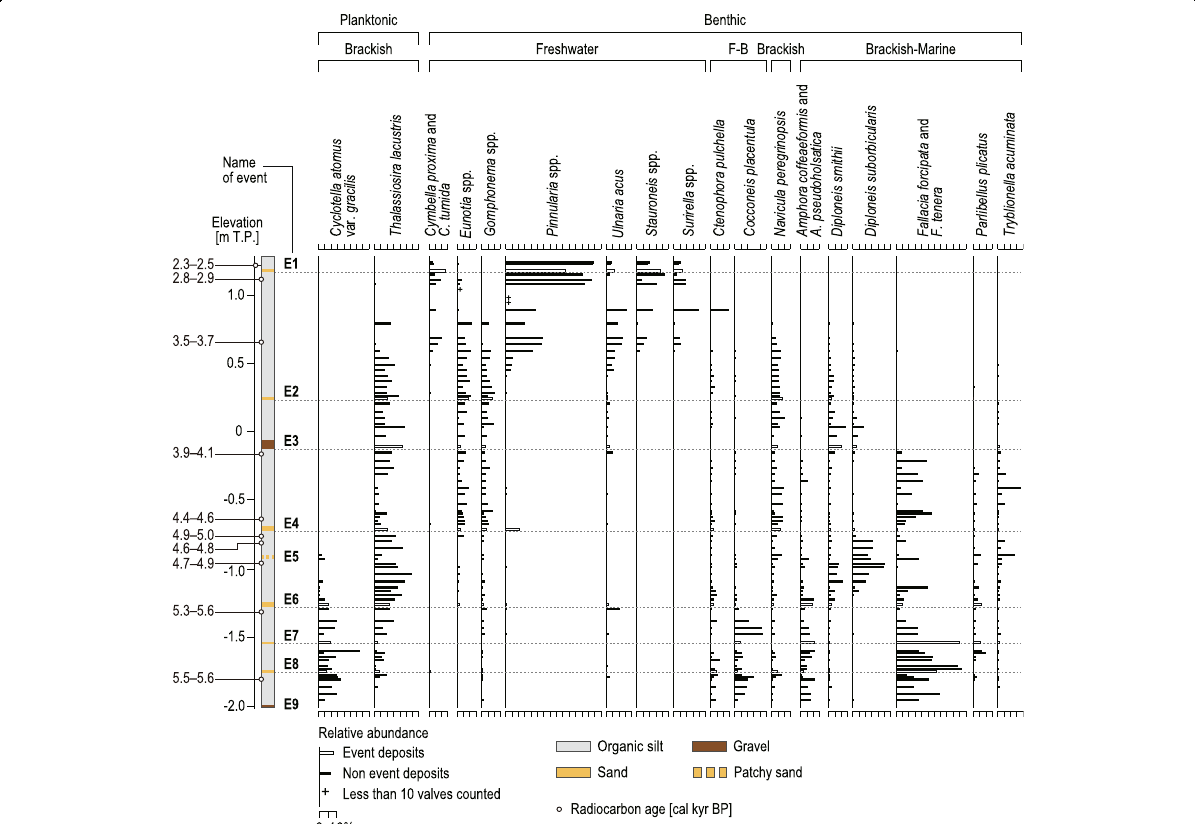
Fig. 5 Fossil diatom assemblages between − 2.02 and 1.28 m elevation (between 120 and 450 cm depth) in core MG05. F-B means freshwater-brackish